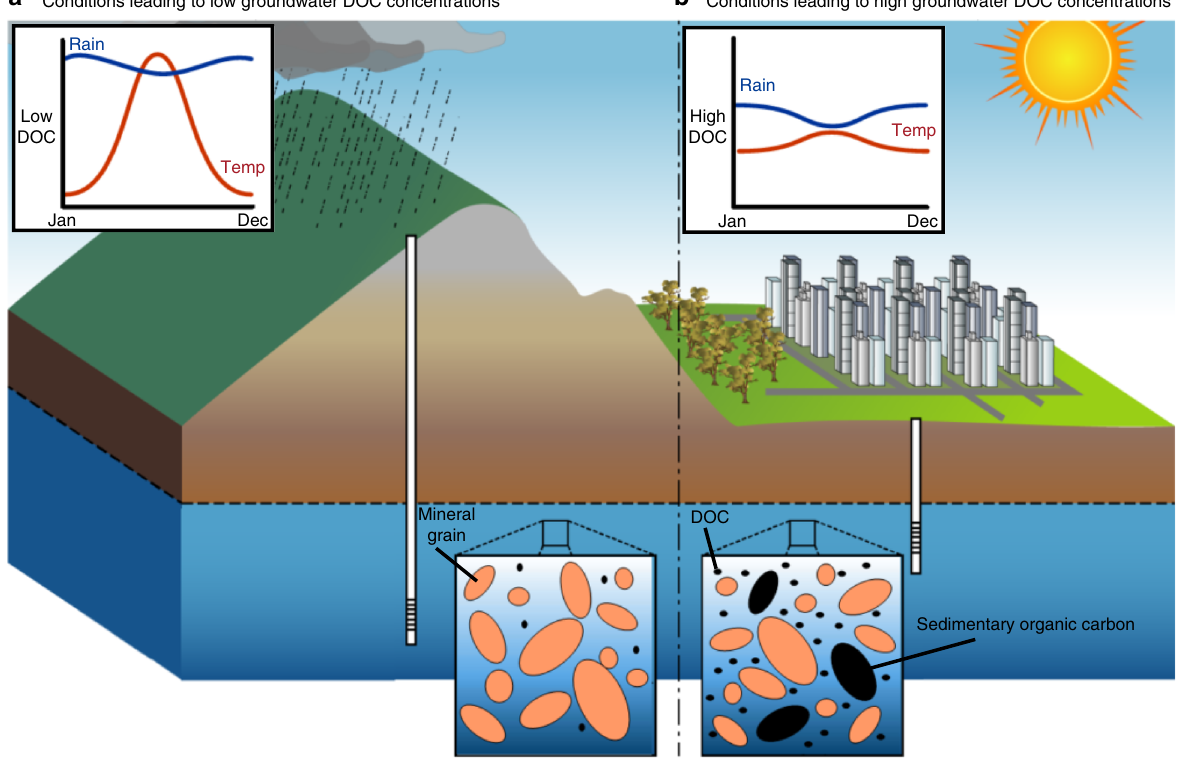
Fig. 2 Factors and processes leading to low and high groundwater DOC concentrations. a Conditions leading to low groundwater DOC concentrations. b Conditions leading to high groundwater DOC concentrations. Factors negatively correlated with groundwater DOC concentrations include increasing pH, DO, Na and Si, precipitation in the wettest and driest months, temperature in the warmest quarter, sample depth, elevation and aquifer age. Factors positively correlated with groundwater DOC concentrations include Mn, Ca, Fe, and K, groundwater temperature and temperatures in the wettest quarter. Urban land use was found to be 18% and 19% higher in groundwater DOC concentrations than agricultural and natural land uses,